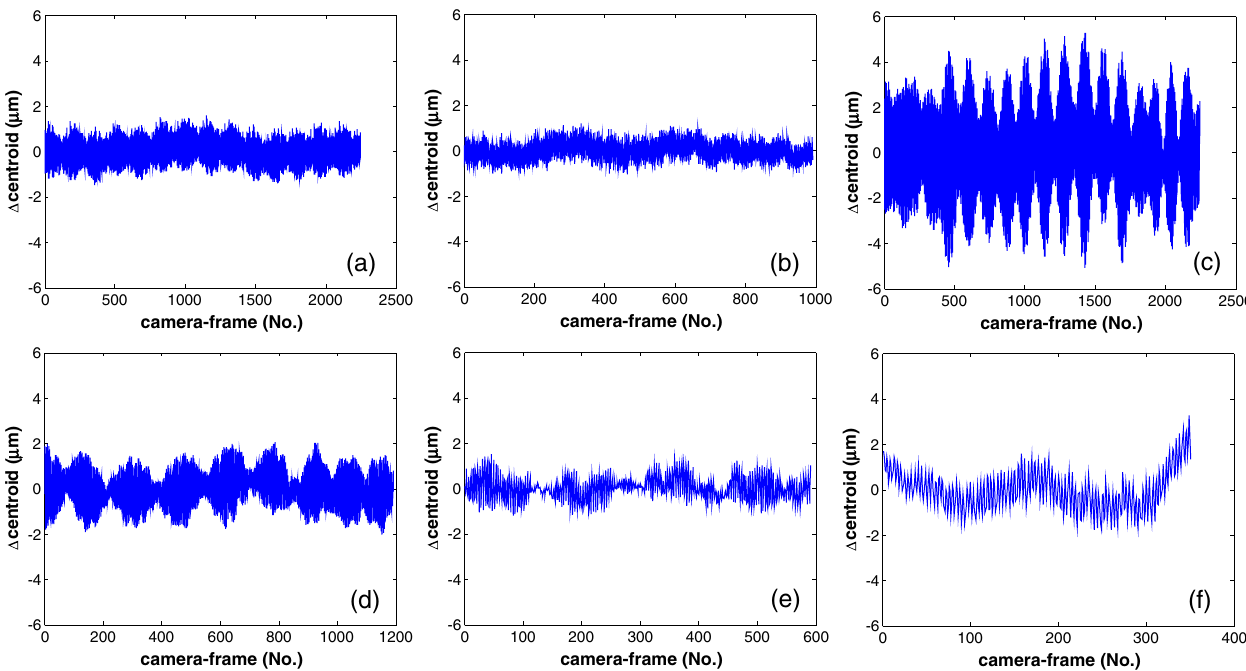
FIG. 4. Measured variations vs time — i.e., vs camera frame number — of the position of the wire centroid — Δ centroid — with respect to the reference value as a function of the motor speed: (a) 0 . 1 mm = s; (b) 0 . 4 mm = s; (c) 0 . 5 mm = s; (d) 1 . 0 mm = s; (e) 2 . 0 mm = s; and (f) 3 . 0 mm = s. The camera frame rate is 565 fps, the camera exposure time is 1